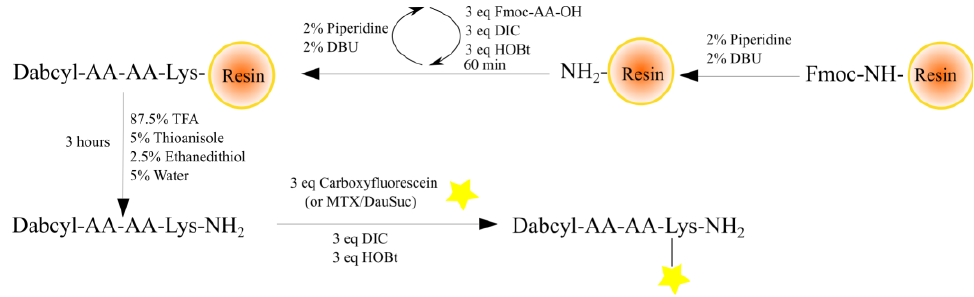
Figure 1. Structures of the used non-natural aromatic amino acids, AMBA, PABA and NAPH.